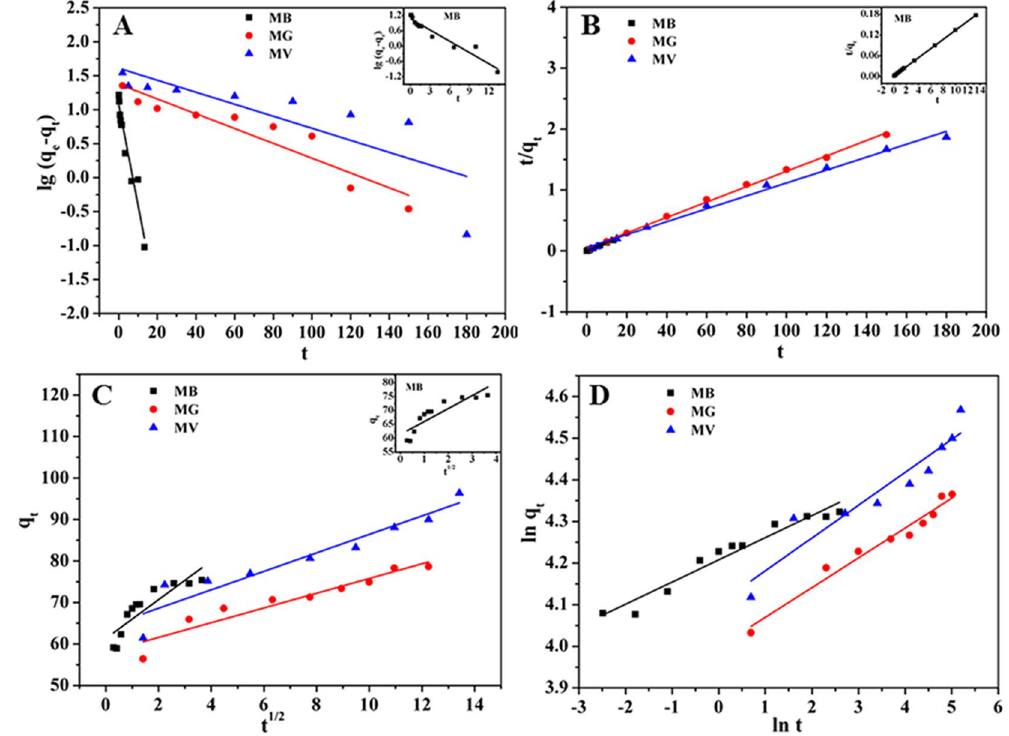
Figure 4. Pseudo-first-order kinetics ( A ), Pseudo-second-order kinetics ( B ), Intraparticle diffusion kinetics ( C ) and Bangham kinetics ( D ) for adsorption of MB and MG ( m = 5 mg, C 0 = 40 mg L − 1 , V = 10 mL, pH = 6, temperature was 298 K), MV ( m = 4 mg, C 0 = 40 mg L − 1 , V = 10 mL, pH = 6, temperature was 298